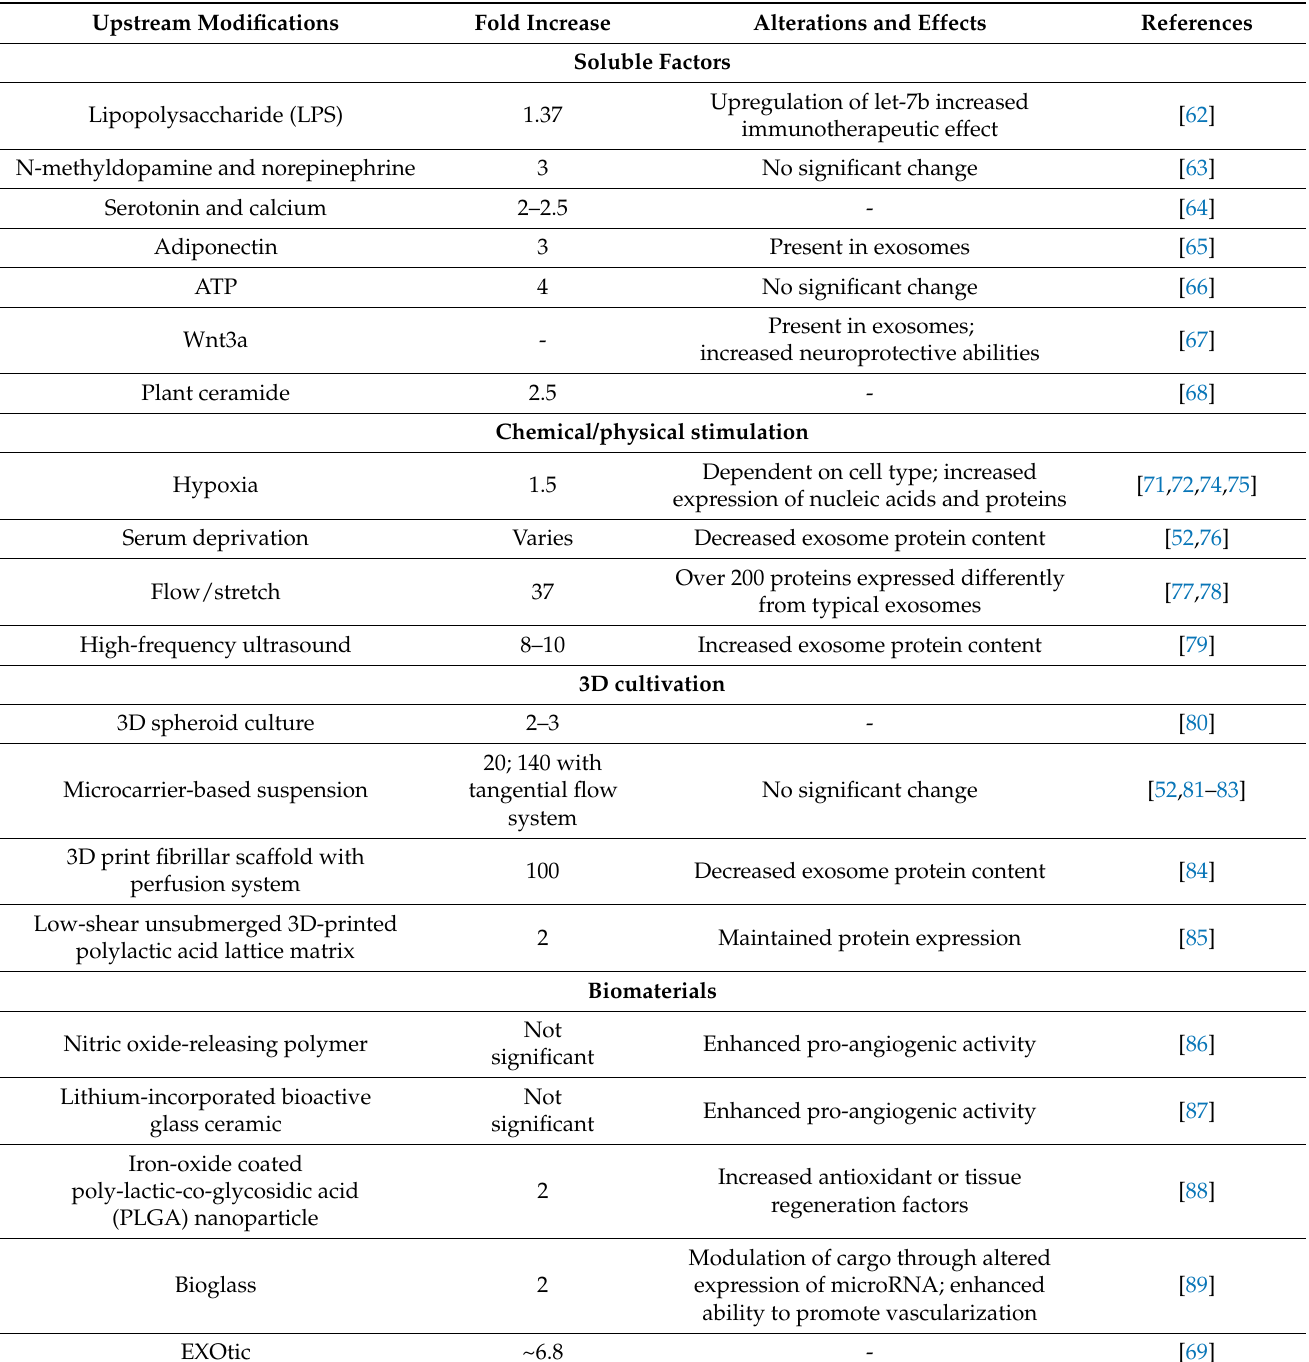
Table 3. Comparison of different upstream modifications for increased exosome production and their reported fold increase and